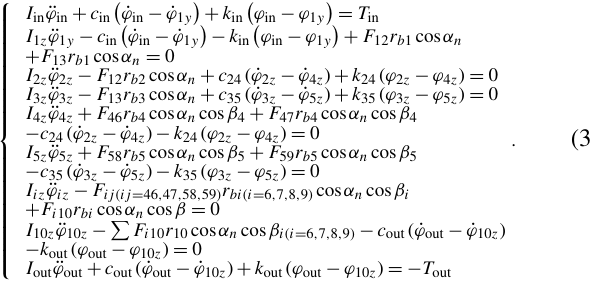
The generalized vibration displacement vector δ with 32 degrees of freedom can be expressed as Eq. (1). Here, x i , y i and z i are the transverse bending deformation of each gear in the x direction, y direction and z direction, respectively. ϕ iz , ϕ in and ϕ out are the torsional angular displacement of gear i , prime mover and load